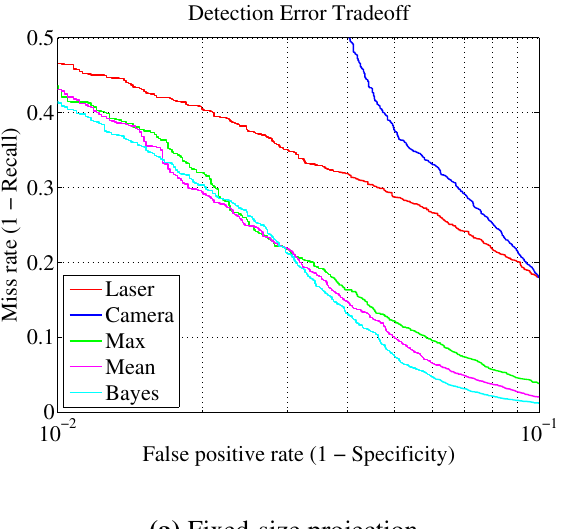
Figure 9. Outdoors experiment detection error tradeoff curves. The curves are plotted for each sensor individually and, also, for the three fusion techniques. Fixed-size (a) and adaptive (b) projection techniques are